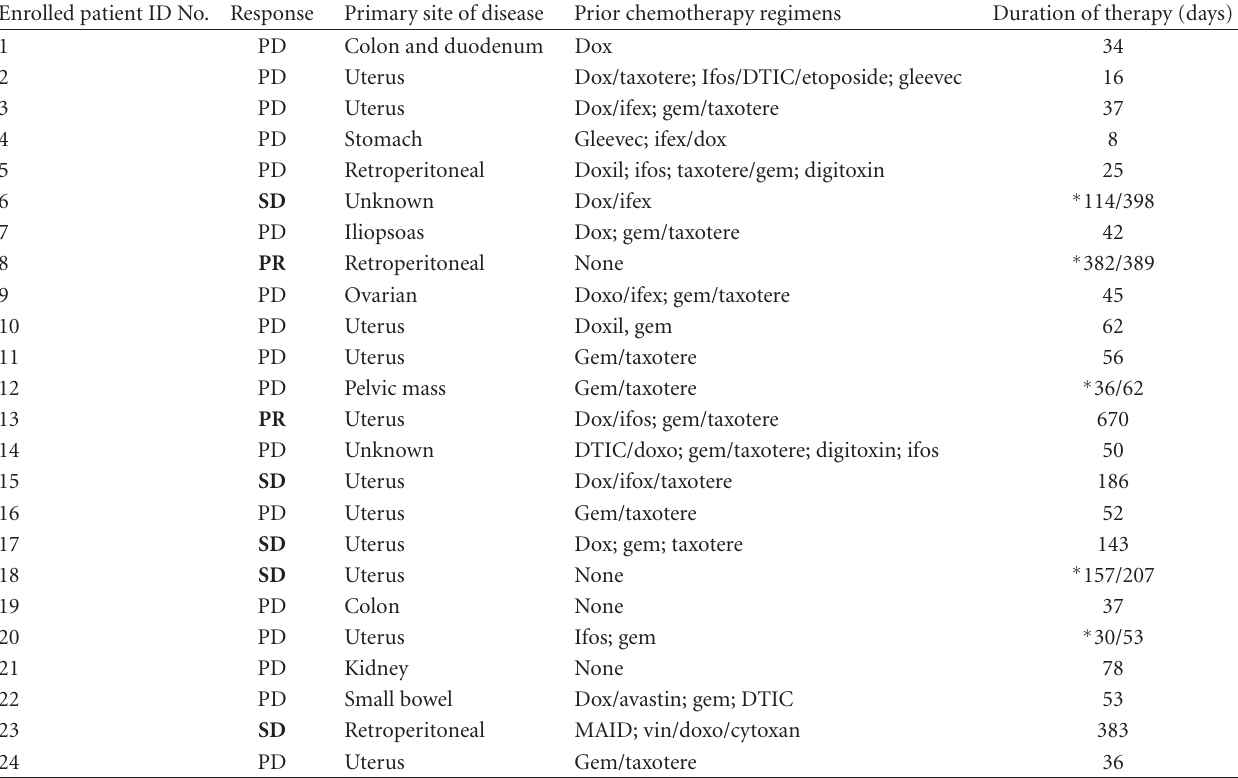
∗ For the 5 patients who discontinued thalidomide early, the fraction represents duration of therapy in days for Temodar + Thalidomide over total days of therapy with Temodar.